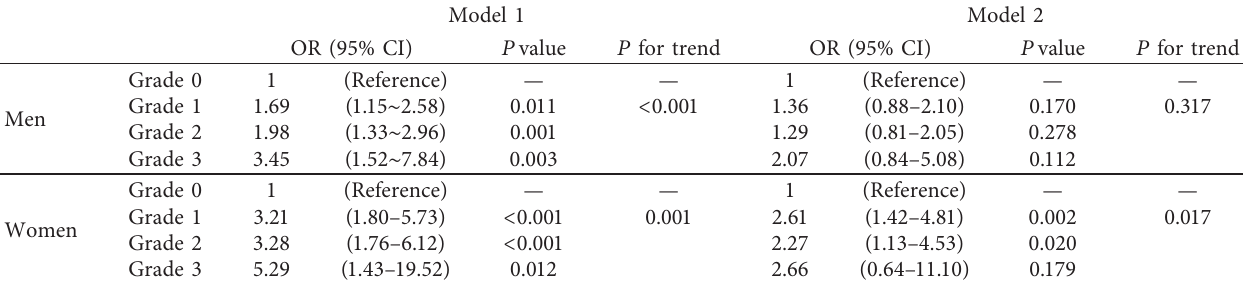
Table 3: Summary of the regression analysis of the correlation between coronary stenosis and NAFLD by sex.